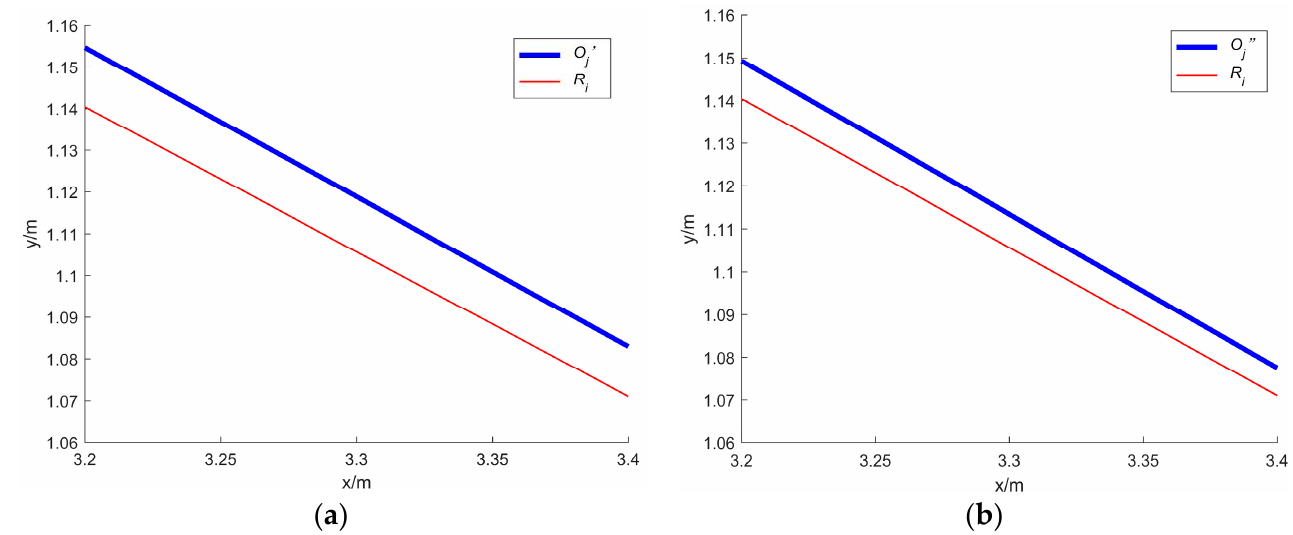
Figure 15. Two frames of partial magnification of laser point cloud segment: ( a ) distribution of straight-line segment of point cloud after rotation; ( b ) distribution of straight-line segment of point cloud after rotation and translation.